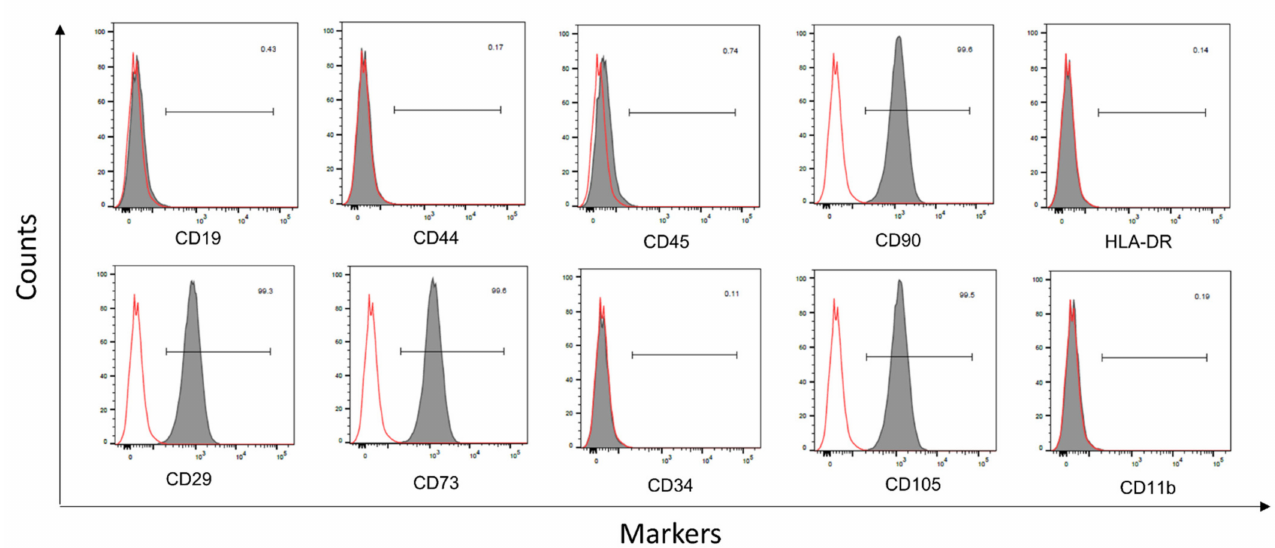
Figure 3. Flow cytometric results of passage 3 HDPSCs. Representative histograms showing antigen expression in bone- marrow-derived MSC. From left to right CD19, CD44, CD45, CD90, HLA-DR, CD29, CD73 CD105, CD73, CD34, CD105 and CD11b. Black-filled histogram: antigen expression; solid red line: auto-fluorescence control.